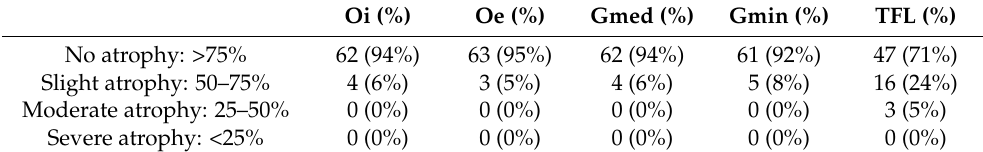
Table 3. Post-operative A/N ratio of M-CSA atrophy grade of each muscle.